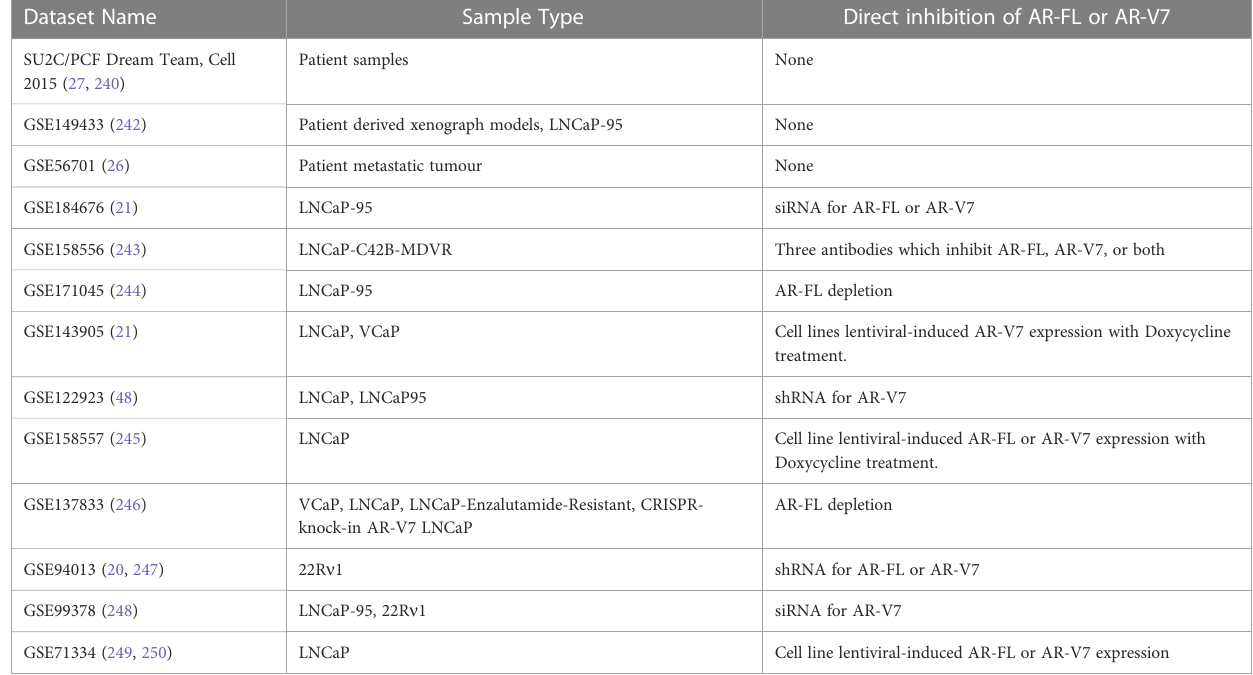
TABLE 2 Datasets that can be utilised to determine AR-V7 target